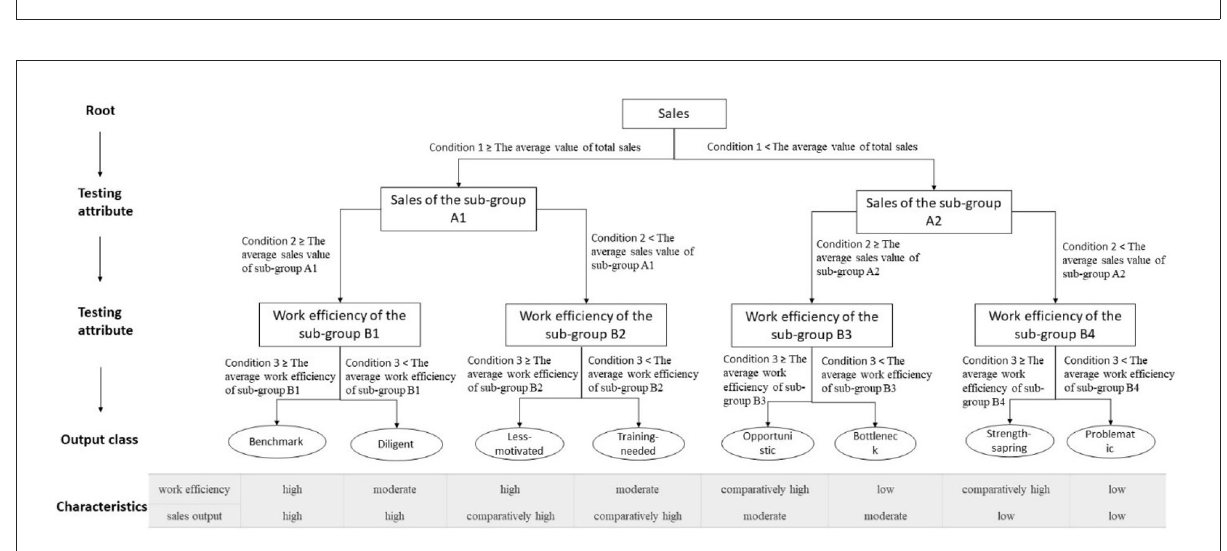
FIGURE2 The salespeople performance evaluation